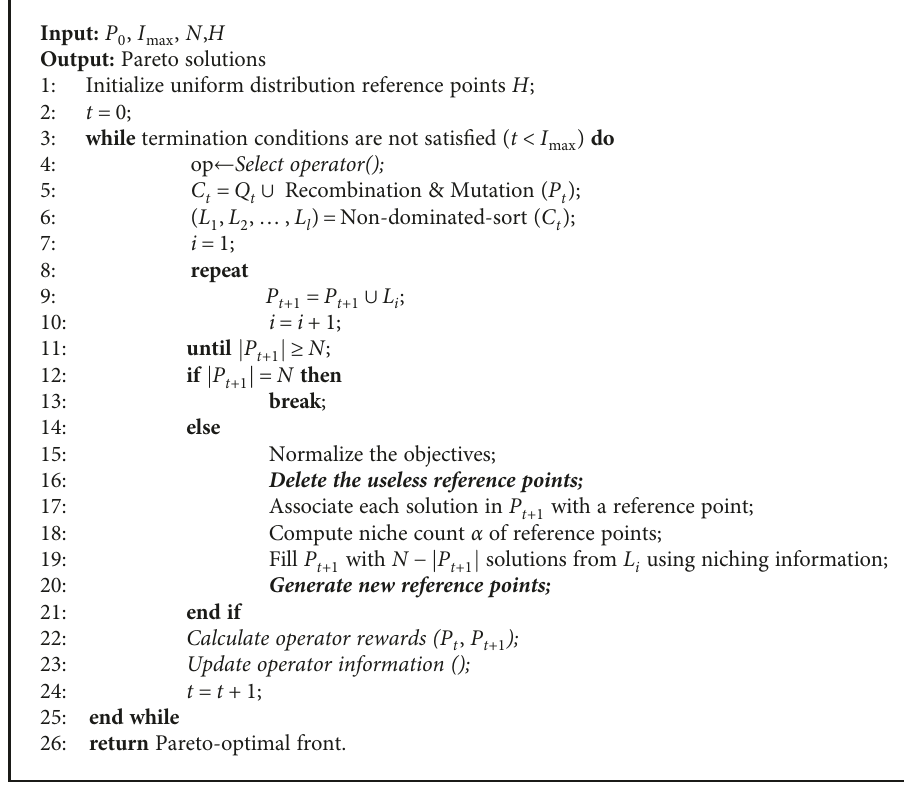
Algorithm 2: The Proposed NSGA-III Algorithm.